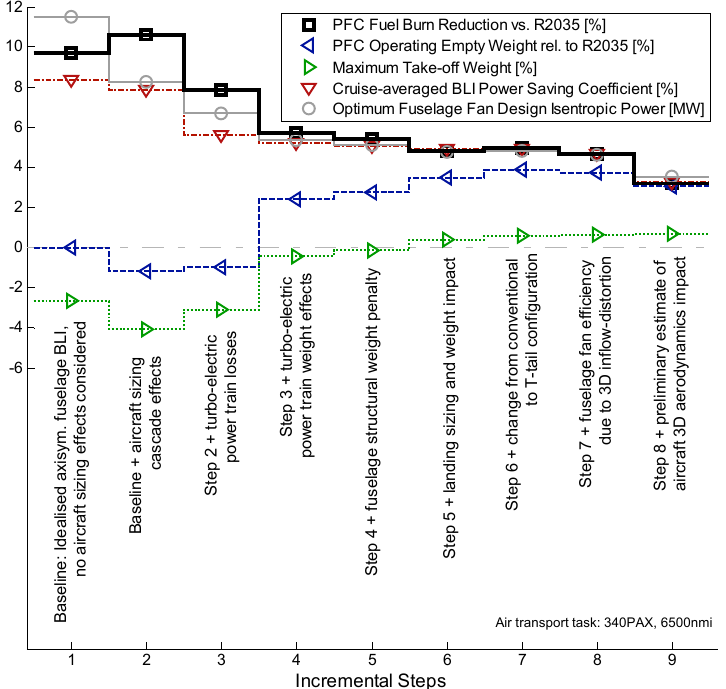
Figure 37. Stack-up of effects analysis on fuel burn reduction of CENTRELINE turbo-electric PFC against R2035 aircraft.